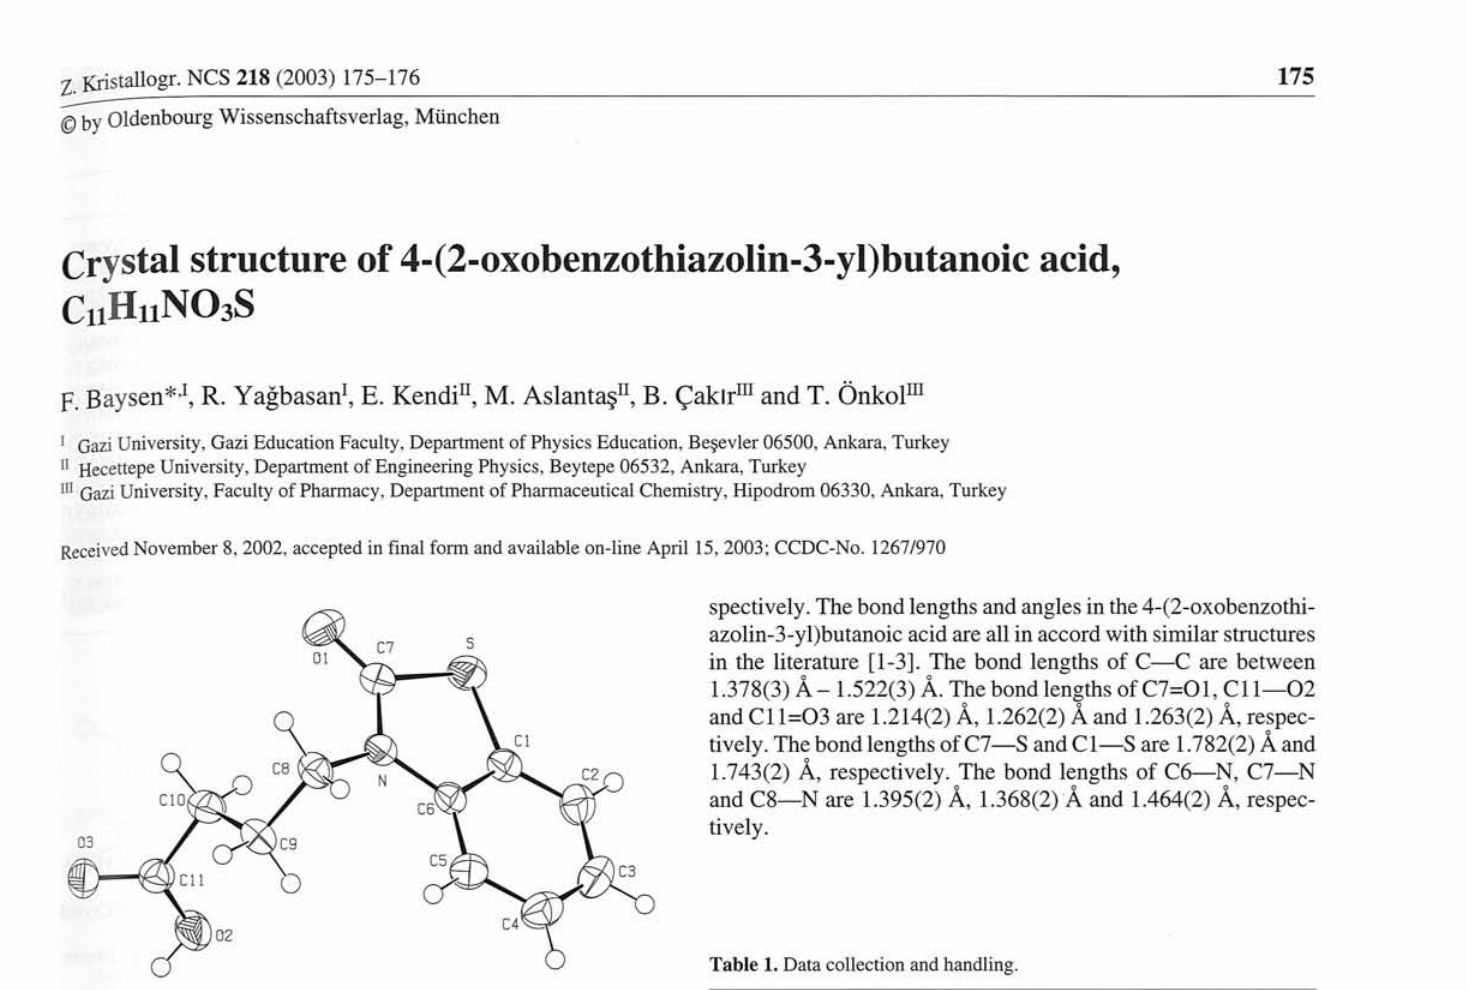
Table 1. Data collection and handling. Crystal: